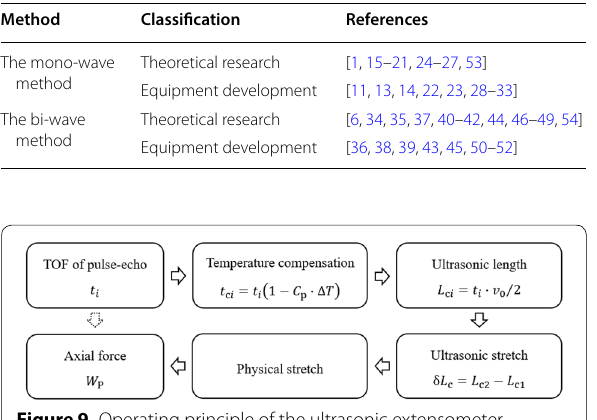
Table 2 Classification of major research of the ultrasonic method